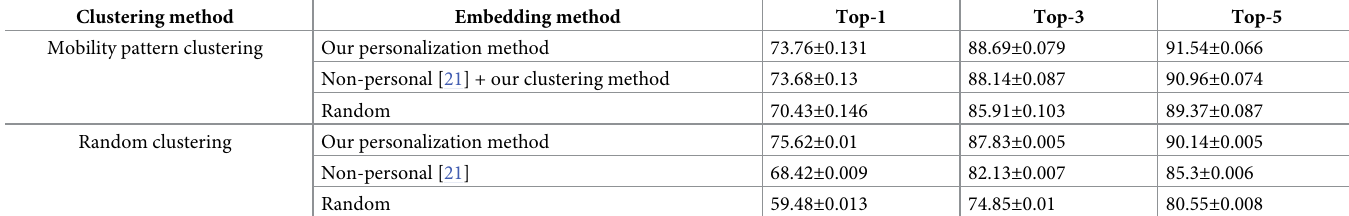
Table 4. Accuracy and standard deviation of each